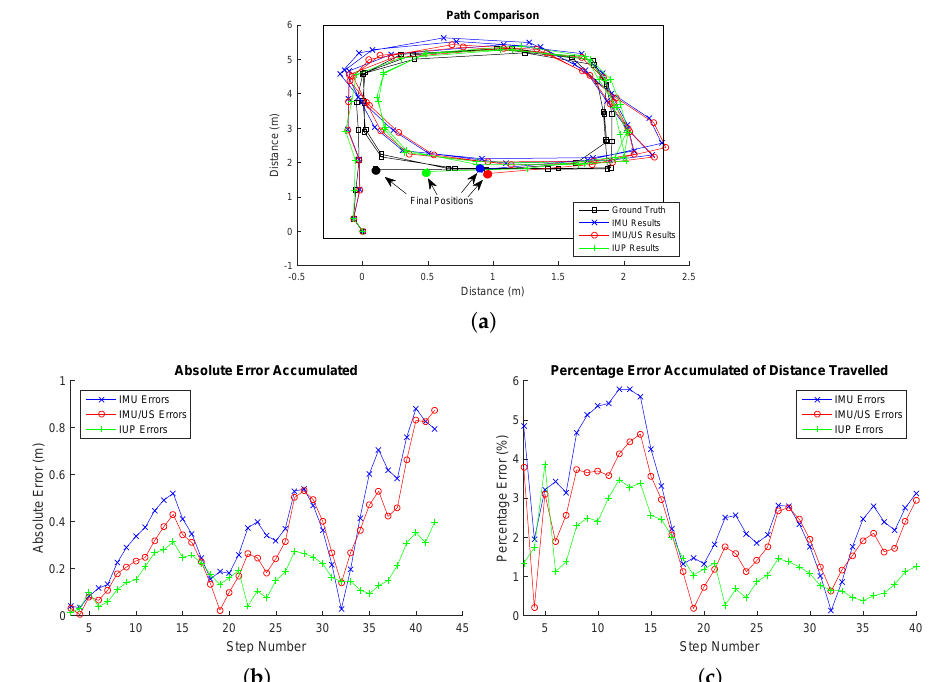
Figure 4. ( a ) The tracked walking paths by the inertial measurement unit (IMU), IMU/ultrasound (US) and inertial/ultrasound/particle filter (IUP) systems for trial 1 of Type 1 walking compared to the ground truth position measured simultaneously by a Vicon motion capture system. ( b ) The absolute errors of the IMU, IMU/US and IUP systems at each single step for trial 1 of Type 1 walking. ( c ) The percentage errors of the IMU, IMU/US and IUP systems at each single step for trial 1 of Type 1 walking.